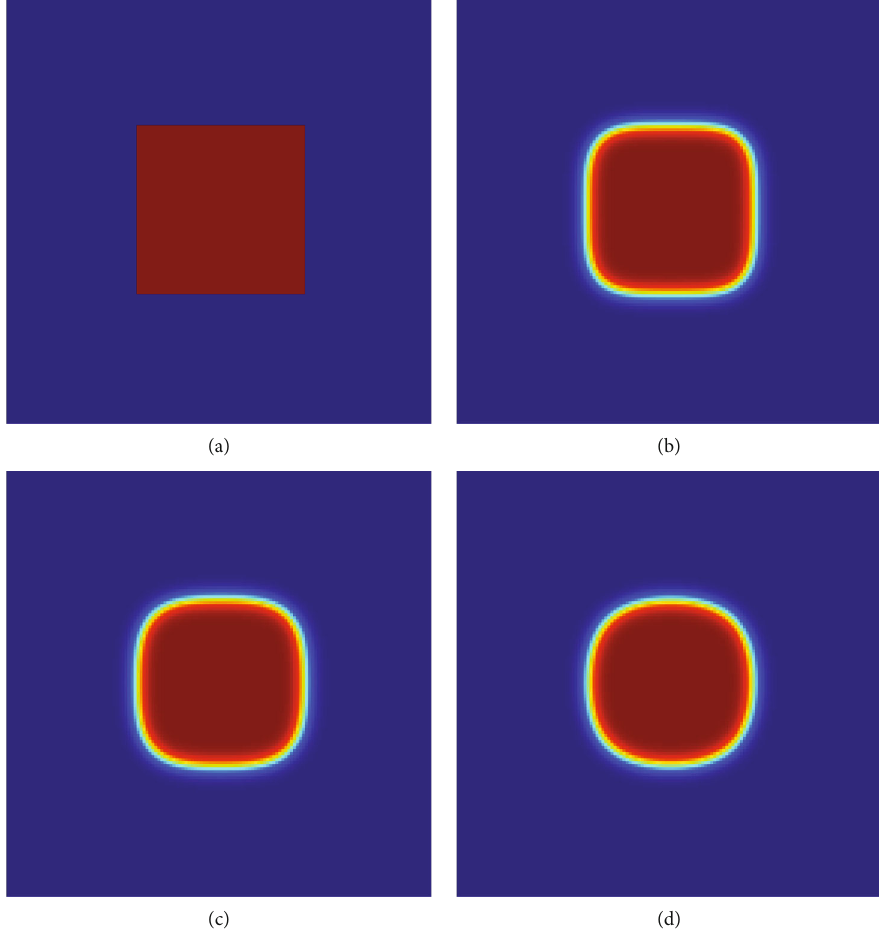
ffiffiffiffiffiffiffiffiffi p 0 : 02 in square domain ð − 5, 5 Þ × ð − 5, 5 Þ at time